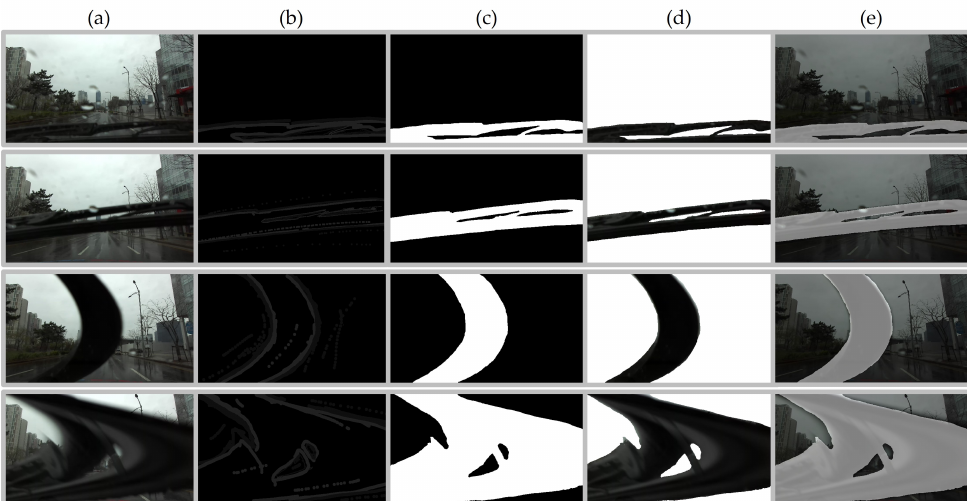
Figure 7. Hand-crafted ground truth wiper mask generation: ( a ) original image; ( b ) manual markings; generated ( c ) binary mask; ( d ) RGB mask; ( e ) concatenated original image ( a ) and binary mask ( c ). Best viewed with zoom-in. Songdo downtown area; Incheon Airport motorway; Dongchun industrial area. Satellite images (1st column) and sample images (2nd–5th columns) of the three areas show the infrastructure differences. Best viewed with